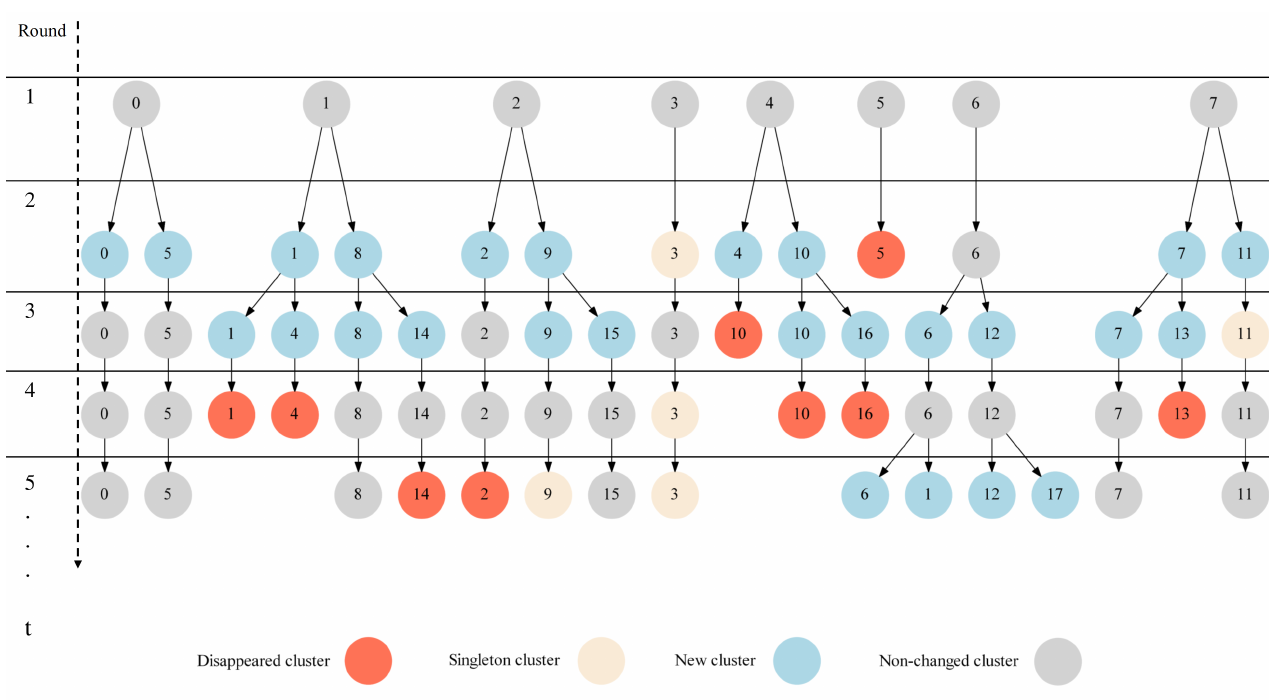
Figure 4. The clustering updates in the first five global communication rounds of the proposed FedCO algorithm applied on the Non-IID FashionMNIST dataset. Notice that the number in the circle represents the cluster